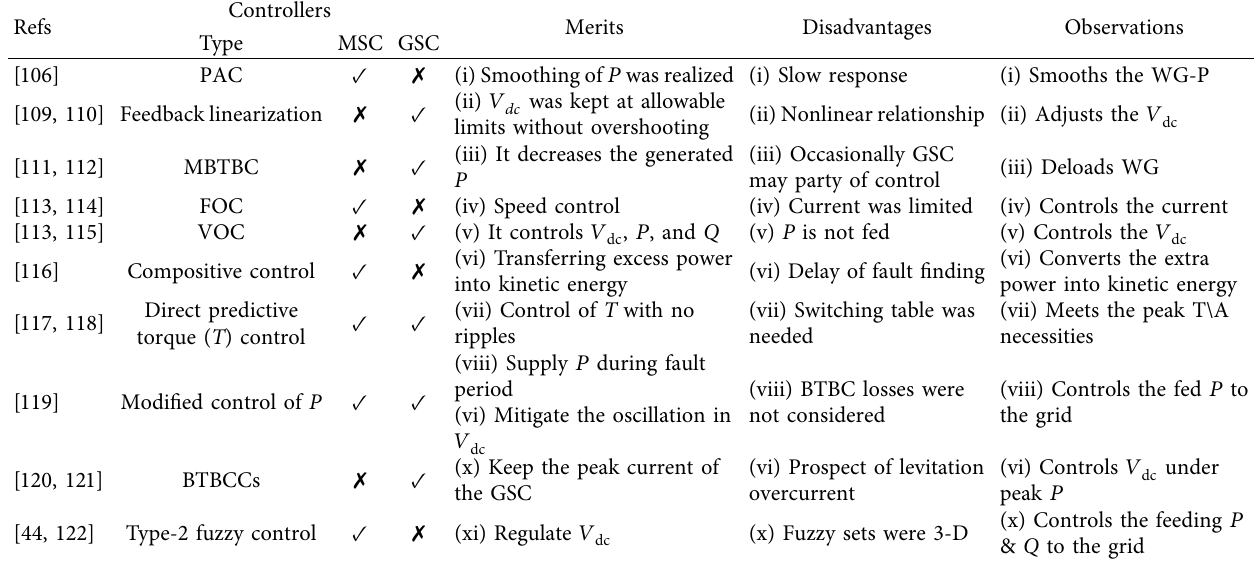
Table 5: Diferent controllers in FRT mechanism of (MSC-GSC) PMSG-based WTG.